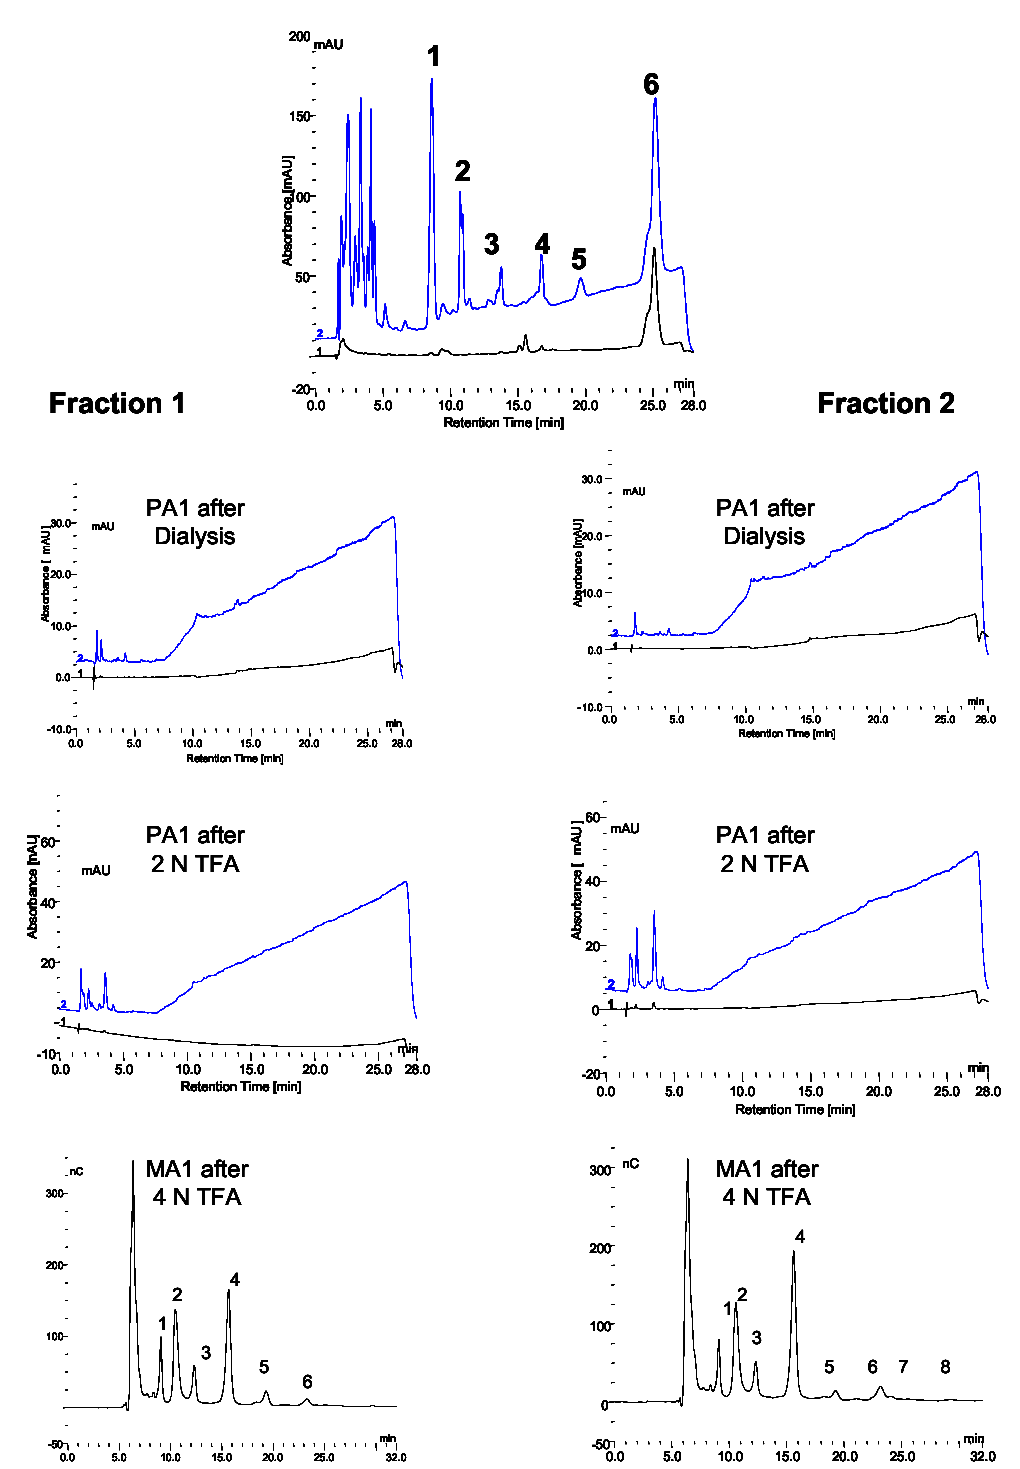
Figure 6. The top chromatogram shows the fractions collected. The three chromatograms on the left show fraction 1 after dialysis, after hydrolysis with 2 N TFA and after hydrolysis with 4 N TFA from top to bottom. The three chromatograms on the right show the same three treatments of Fraction 2. Carbohydrates: 1, myo -inositol:2, epi -inositol: 3, Xylitol: 4, Sorbitol: 5, Manitol: 6, Glucose: 7, Xylose: 8, Galactose.